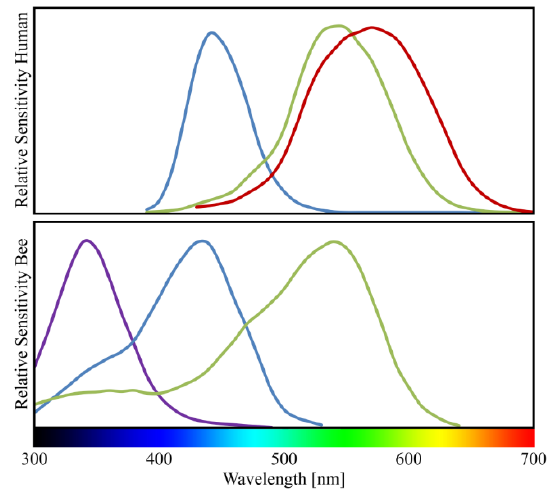
F IGURE 1. Spectral sensitivity of colour photoreceptors. Top: Relative sensitivity of the three human photoreceptor types. The curves peak at 420 nm, 534 nm and 564 nm (Bowmaker et al. 1980). In the UV range of wavelength between 300 nm and 400 nm the photoreceptors are not sensitive (modified from Stockman et al. 1993). Bottom: Relative sensitivity of the three photoreceptor types of the honeybee (Apis mellifera). The curves peak at 344 nm, 436 nm and 544 nm. In the red range of wavelength between 630 nm and 700 nm (red light) the photoreceptors are not sensitive (modified from Peitsch et al.